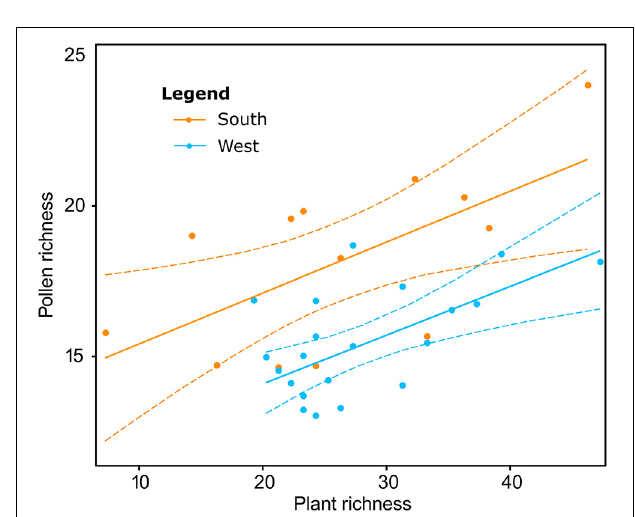
FIGURE 3 | Association between pollen-based and plant-based herbaceous richness showing the influence of a geographical region [South (orange) vs. West (blue)]. Herbaceous plant richness at 6 m scale is used. Linear model with backward selection of variables indicates that plant richness ( t = 4.26, p < 0.001) and region ( t = –5.02, p < 0.001) are significant predictors of pollen richness (determination coefficient R 2 =